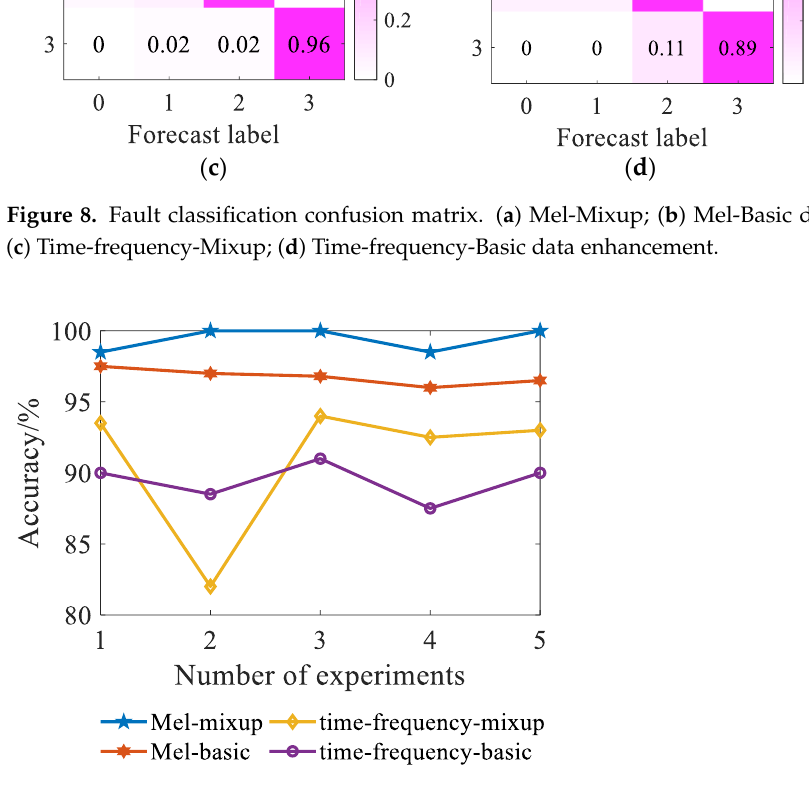
Figure 8. Fault classification confusion matrix. ( a ) Mel - Mixup; ( b ) Mel - Basic data enhancement; ( c ) Time - frequency - Mixup; ( d ) Time - frequency - Basic data enhancement.